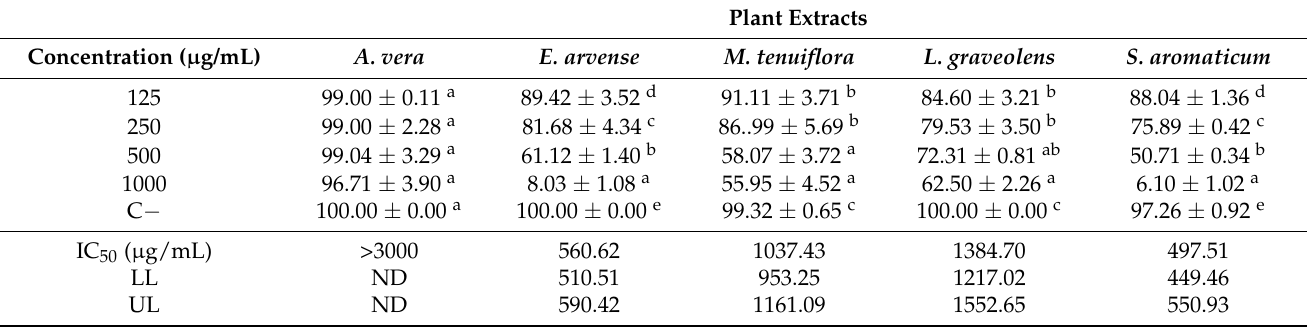
Table 6. Cellular viability in percentage (%) and IC 50 for each evaluated extract. Plant